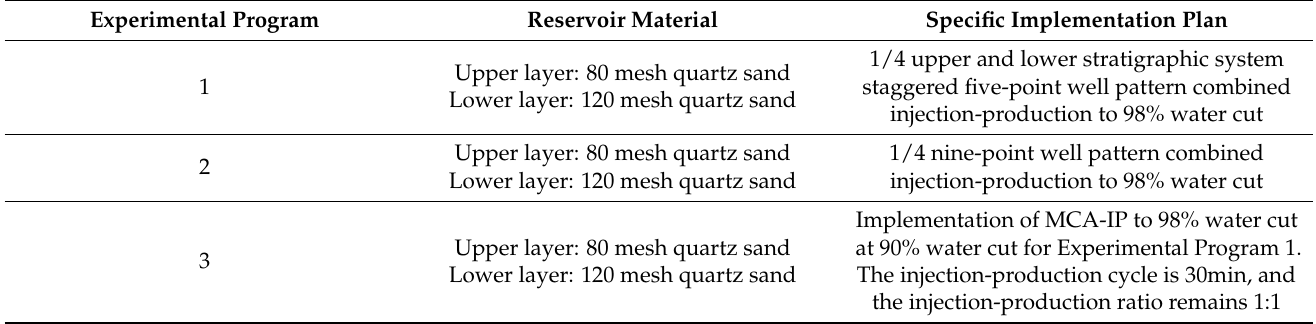
Table 3. Oil reservoir and laboratory experiment parameter table.